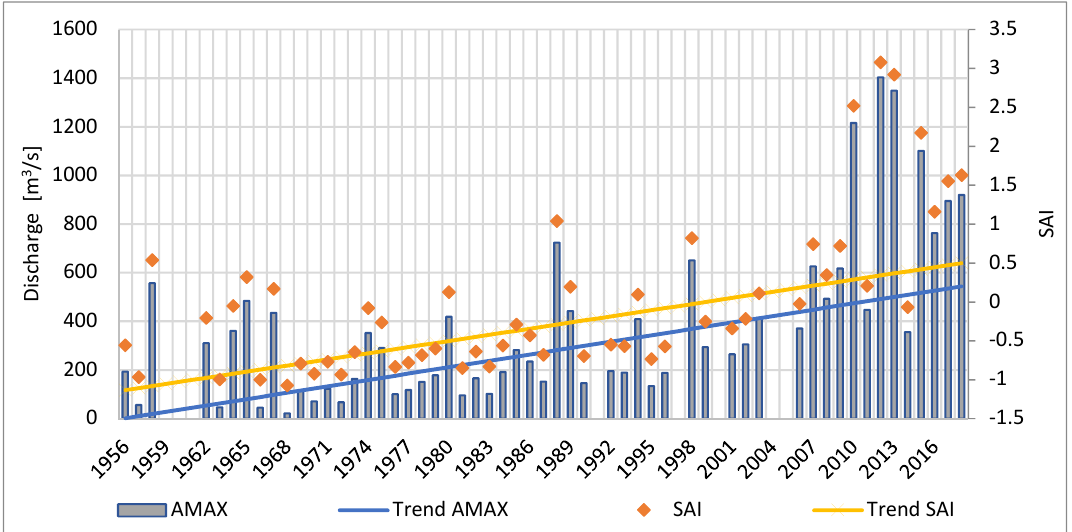
Figure 8. Monotonic linear trends estimated with the Sen approach. Annual maximum discharge and anomalies (SAI) time series.